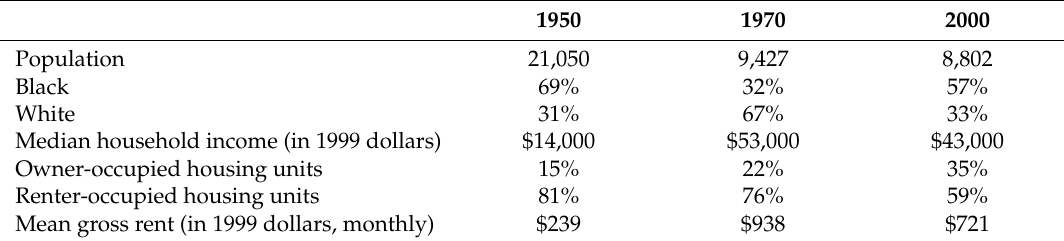
Table 1. Composition of Southwest DC (urban renewal zone) from 1950 to